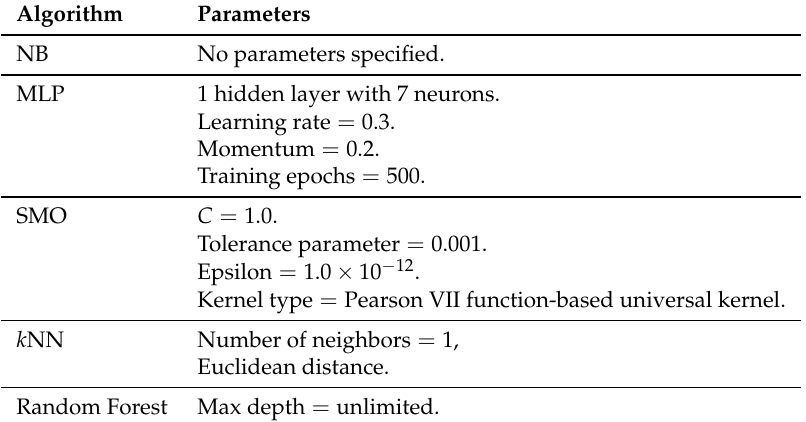
Table 2. Parameter specification for all the classification algorithms used in the experimentation. Algorithm Parameters NB No parameters specified. MLP 1 hidden layer with 7 neurons. Learning rate = 0.3. Momentum = 0.2. Training epochs = 500. SMO C = 1.0. Tolerance parameter = 0.001. Epsilon = 1.0 × 10 − 12 . Kernel type = Pearson VII function-based universal kernel. k NN Number of neighbors = 1, Euclidean distance. Random Forest Max depth = unlimited.